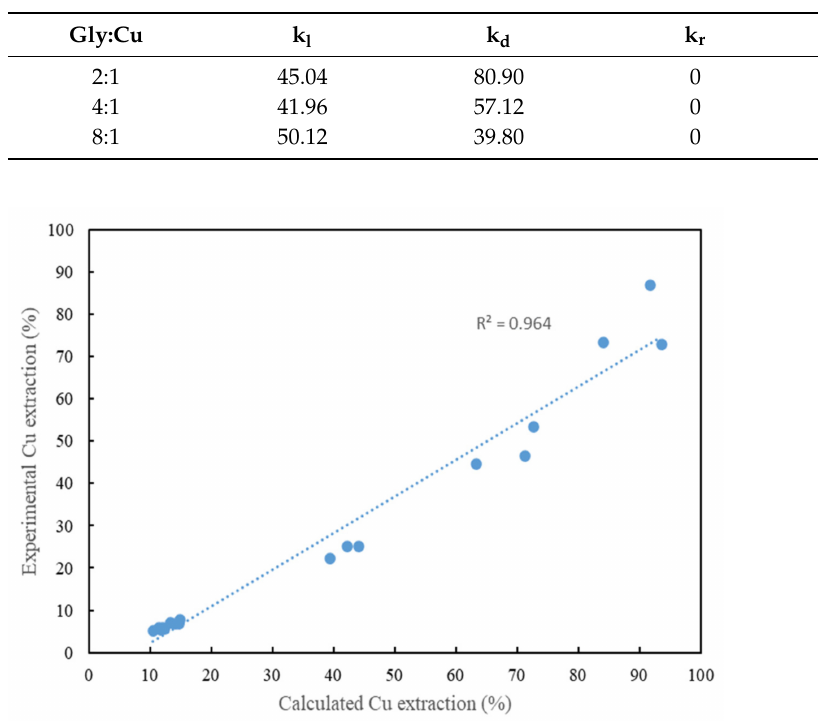
Figure 9. Comparison of experimental Cu extraction and calculated Cu extraction based on the calculated reaction rate values (at different Gly:Cu molar